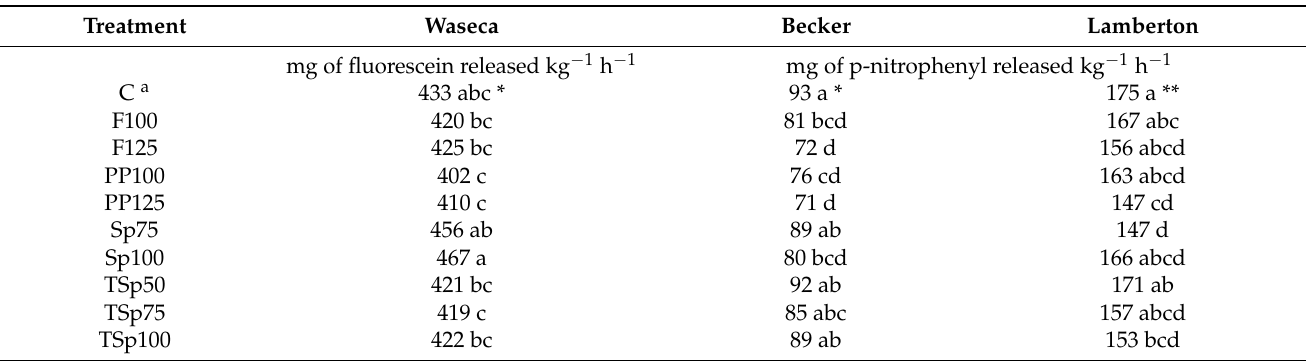
Table 4. Treatment effect on fluorescein diacetate (FDA) hydrolysis at Waseca and on arylsulfatase activity at Becker and